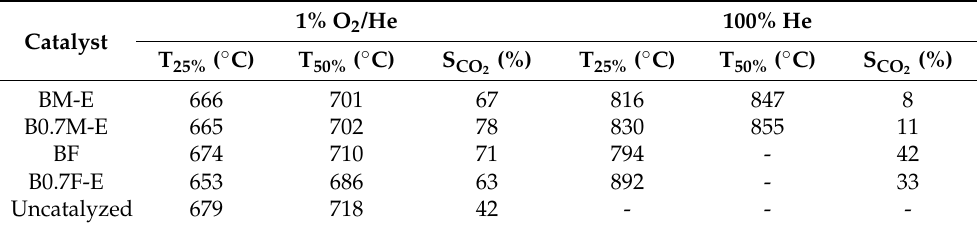
Table 5. T 25% , T 50% , and selectivity to CO 2 (S CO